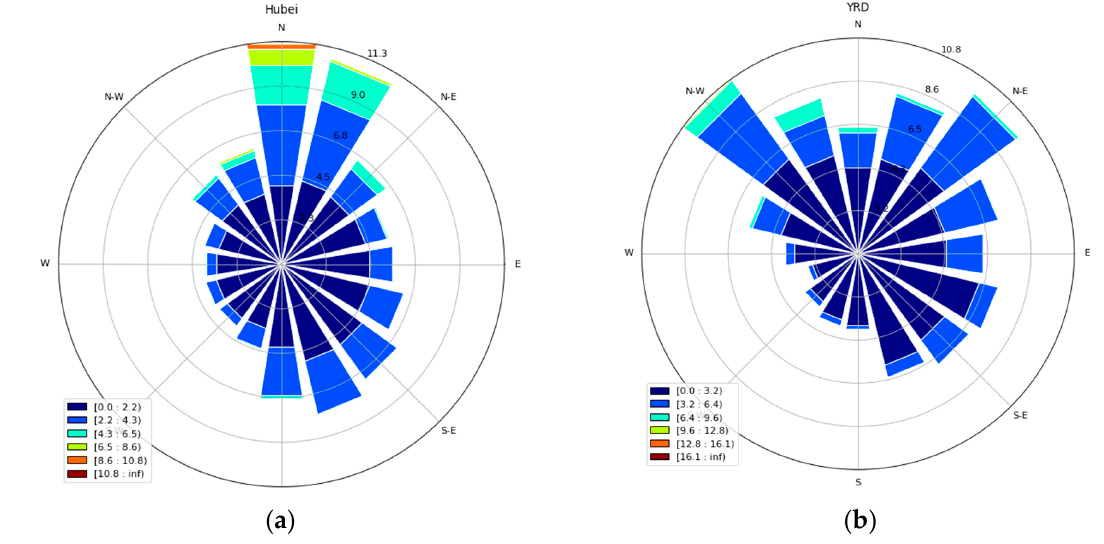
Figure 5. Distribution of wind speed and wind direction of ( a ) Hubei and ( b ) YRD during the SD period.